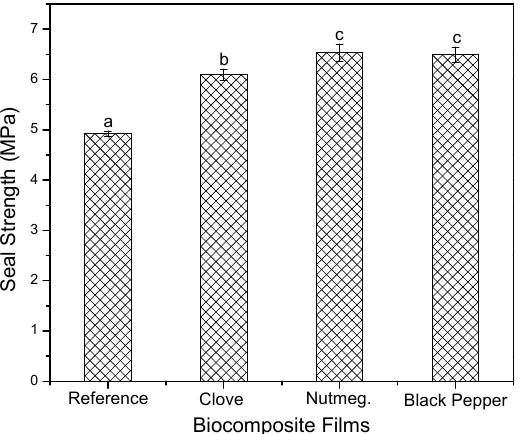
Figure 8. Seal strength of biocomposite films with oleoresins and reference. Different letters in the same column indicate significant differences ( p < 0.05).